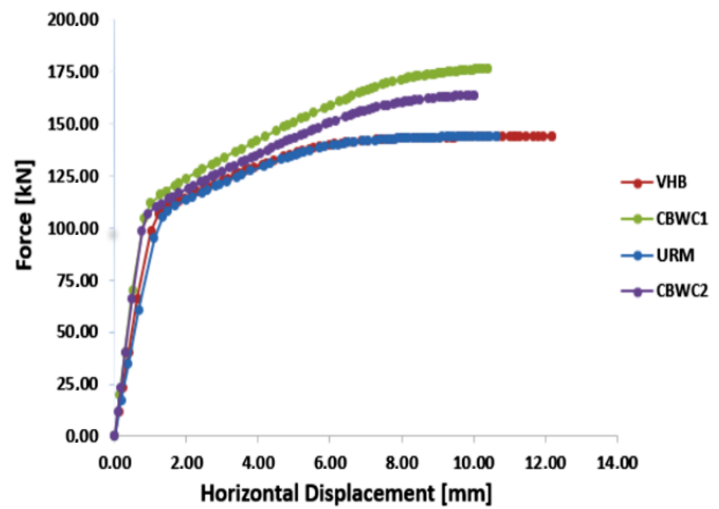
Figure 9. Graph of force–displacement for all four types of masonry blocks.